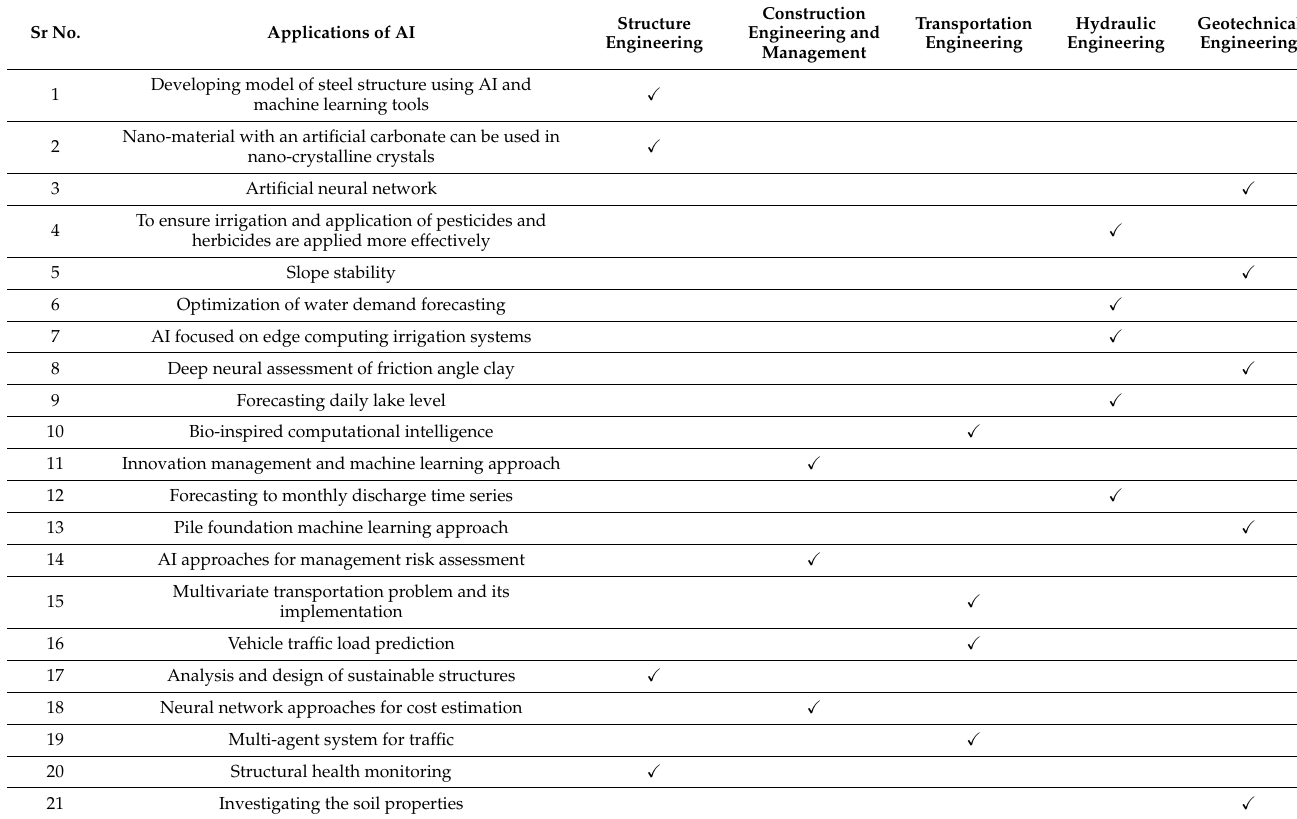
Table 2. Summary of findings of AI in civil